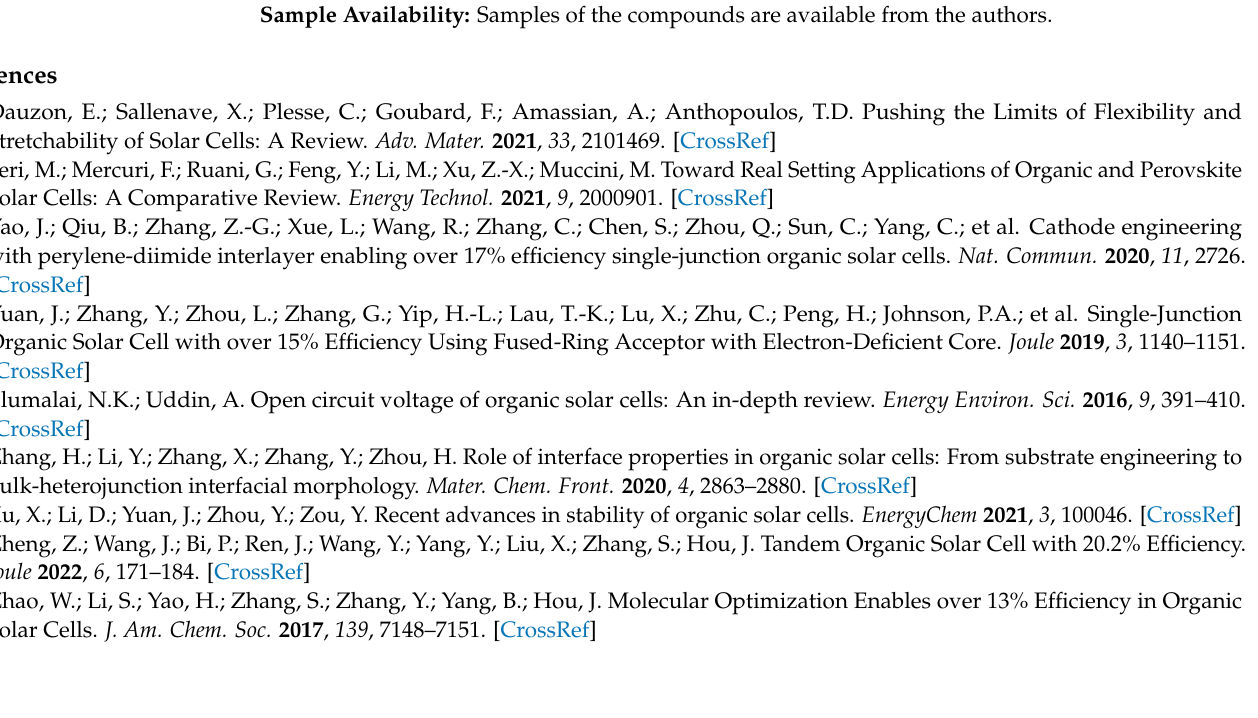
calculation of E factor for molecule 2a , Table S3: Calculation of E factor for reported IDT precursor, Table S4: Calculation of E factor for reported IDT core (4-hexylaryl substituents), Table S5: Calculation of E factor for the IDT dialdehyde core (hexyl substituents), Table S6: E-factor